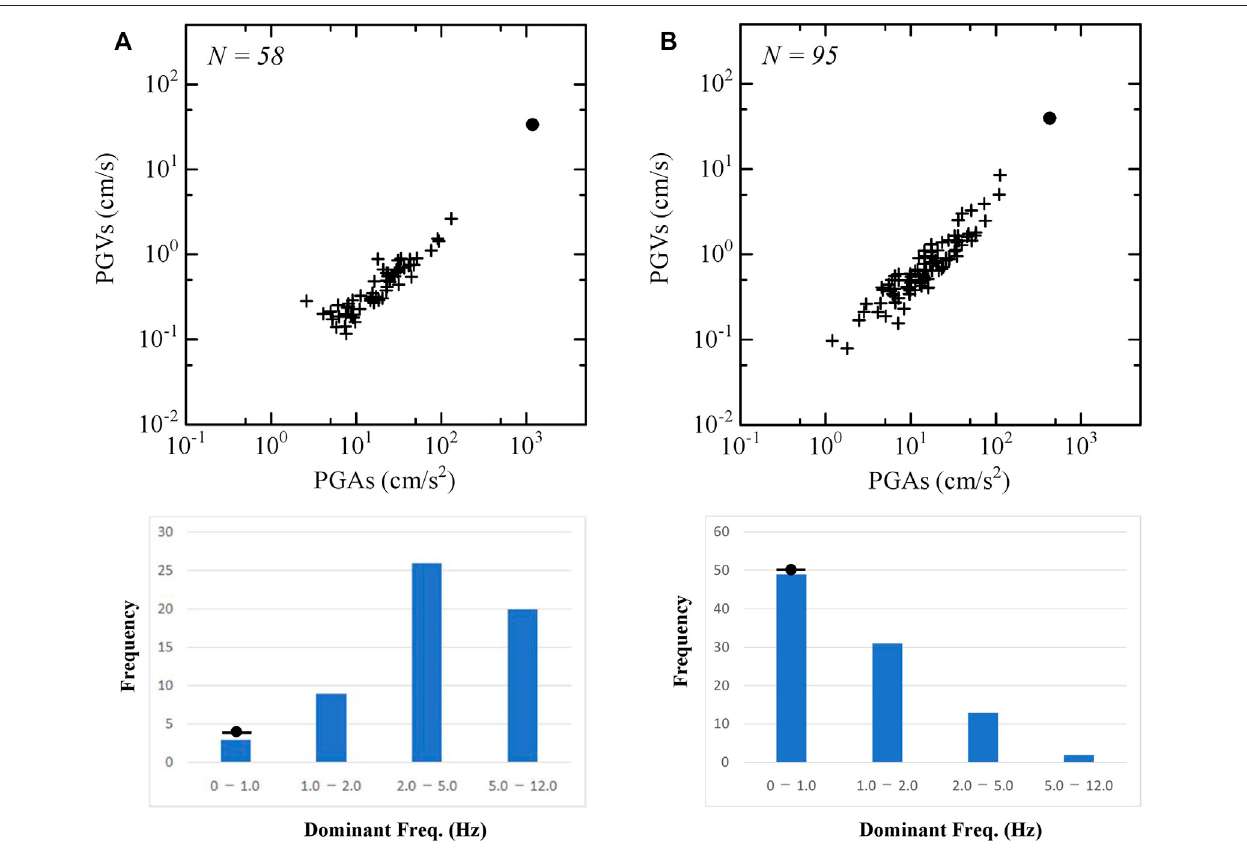
FIGURE 2 | Information of PGAs, PGVs, and the peak frequency in the seismic data used in this study. N in the fi gures indicates the number of earthquakes used. Crossesandacircleinthe fi gureofPGAsandPGVsatKSandSSstationsshowdataofthemoderate-sizedearthquakeswithamagnitude( Mj )of5.0 – 6.0anddataofthe 2011offthePaci fi ccoastofTohokuearthquake( Mw 9.0),respectively.Histogramsofthedominantfrequency(Hz)fordataofthemoderate-sizedearthquakesobserved at KS and SS stations are shown with that of the 2011 off the Paci fi c coast of Tohoku earthquake ( Mw 9.0) by a circle in the fi gure. (A) KS station (B) SS station.